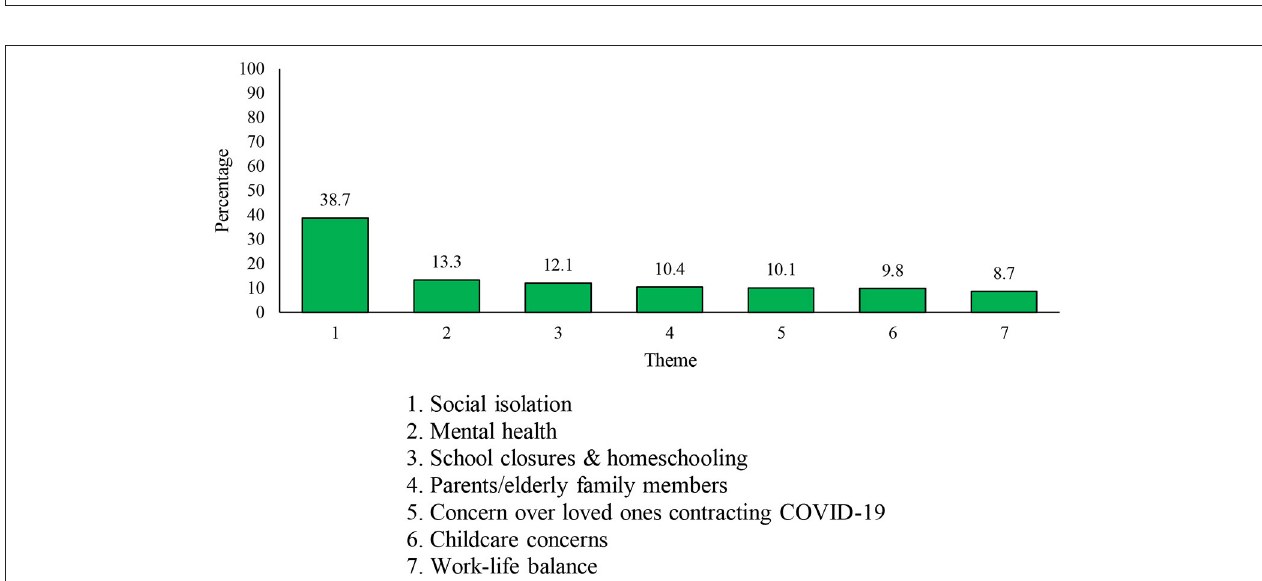
FIGURE 2 | Seven most frequently mentioned work-related challenges by component.